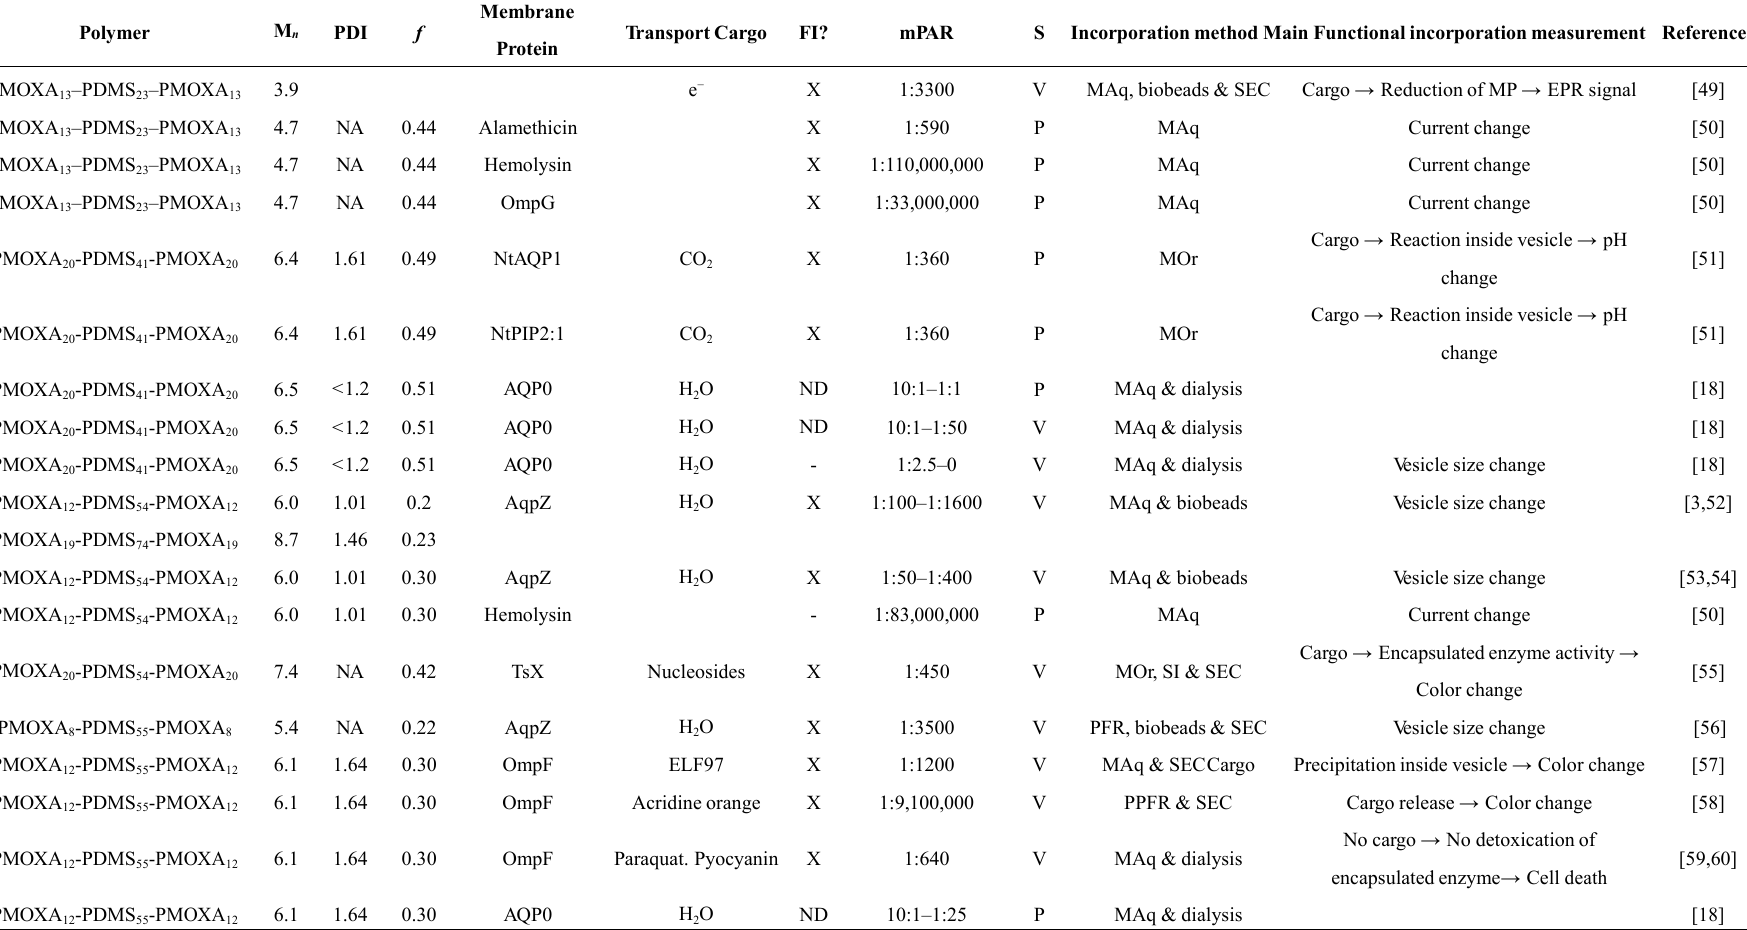
Table 1. Overview of studies of membrane protein incorporation into amphiphilic block copolymers. Most studies are done with the porin OmpF, followed by AqpZ. For explanations please refer to the list of